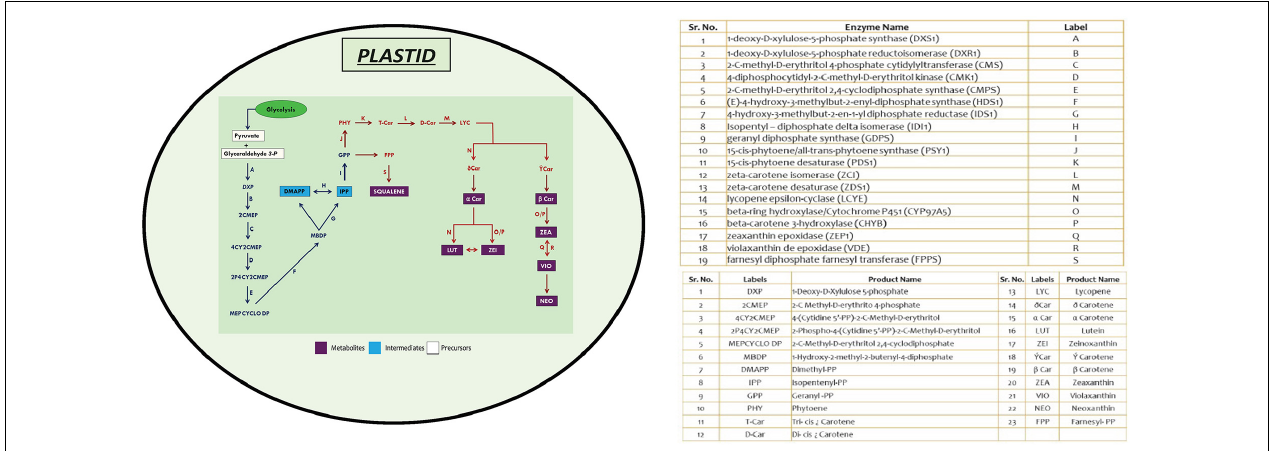
FIGURE 1 | An overview of methyl erythritol phosphate (MEP) pathway in microalgal cells depicting carotenoid and squalene biosynthesis. Genes marked in blue are initial steps of MEP pathway, and those in red are involved in high-value renewables (HVR) (squalene and carotenoids) synthesis.